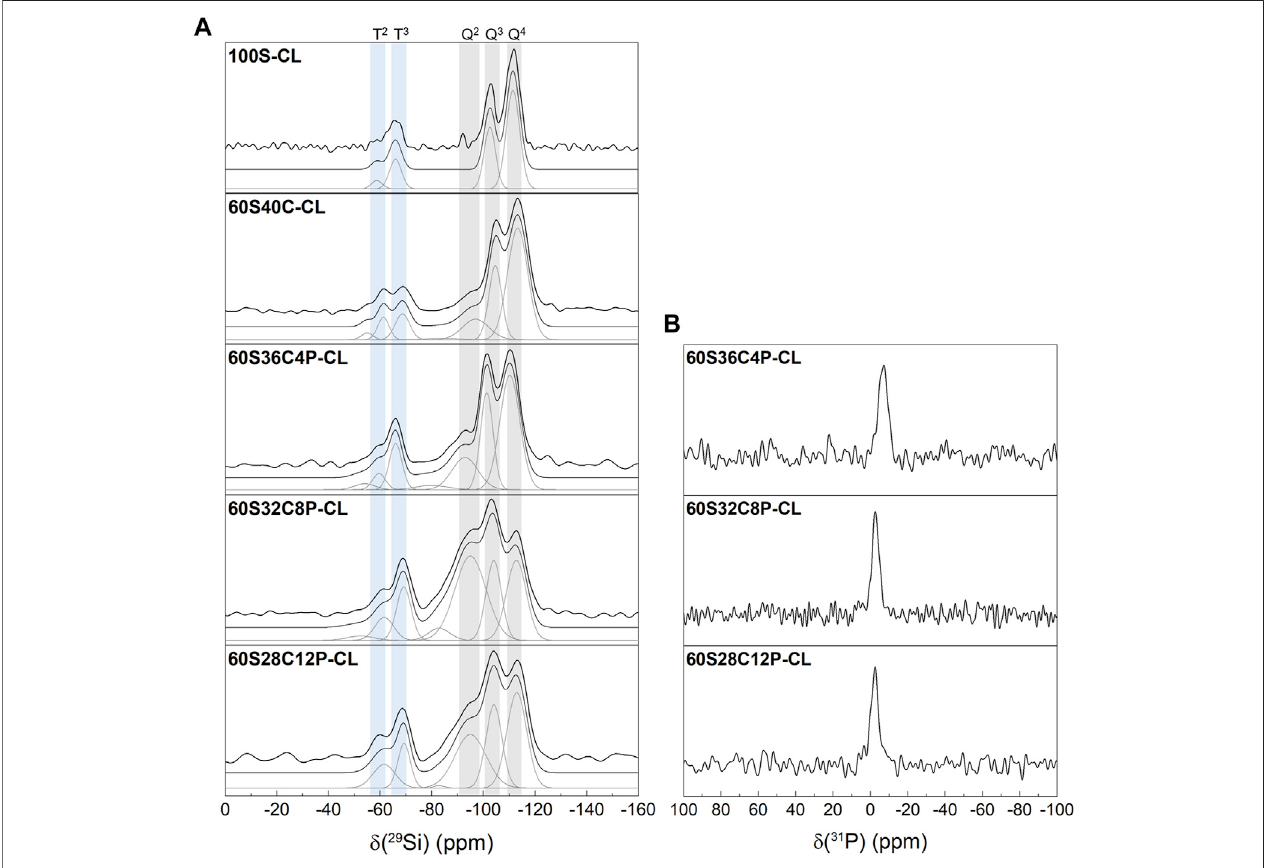
FIGURE 3 | Single pulse solid-state MAS NMR of the SiO 2 -CaO-P 2 O 5 /PTHF/PCL-diCOOH hybrids: (A) 29 Si MAS NMR with shaded regions highlighting peaks attributed to Q and T species following the peak fi tting to calculate the abundance of each silicon species; (B) 31 P MAS NMR.